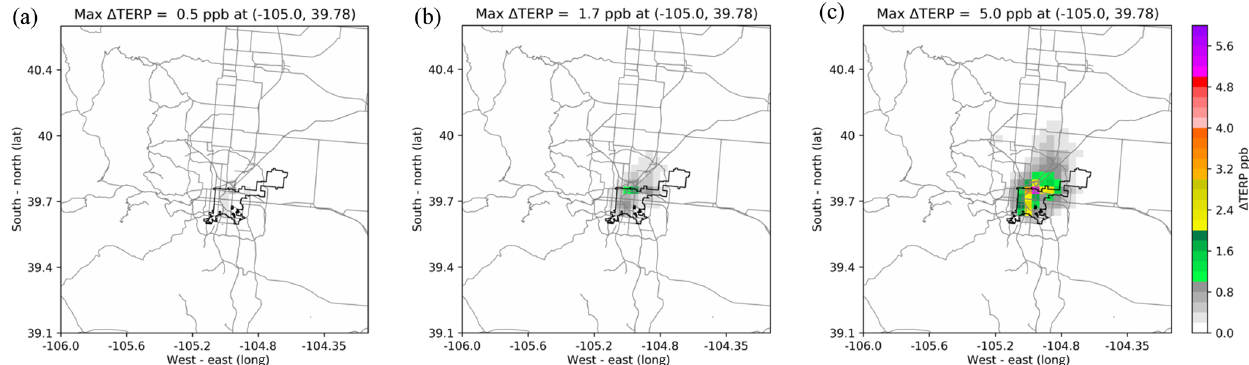
Figure 2. The maximum increase in TERP concentrations (ppb) for Denver County and Front Range over the entire 90d simulation for the